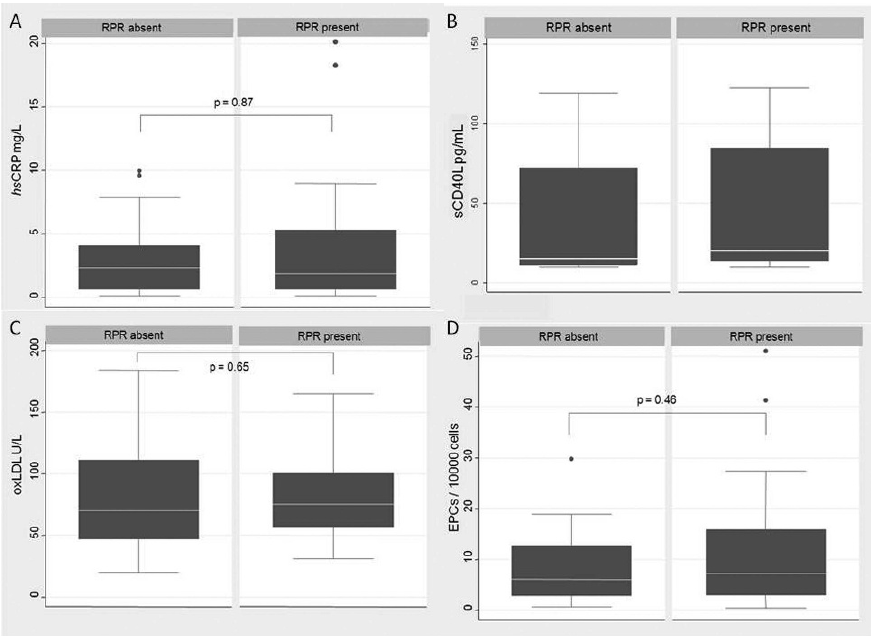
Figure 1 - The levels of (A) high-sensitivity C-reactive protein ( hs CRP), (B) soluble CD40 ligand (sCD40L), (C) oxidized low-density lipoprotein (oxLDL), and (D) endothelial progenitor cells (EPCs) in patients without and with residual platelet reactivity (RPR). The data are presented as box plots displaying the mean, 25th and 75th percentiles and the minimum, maximum, and outlying values. In Figure 1-B, one outlier was excluded.